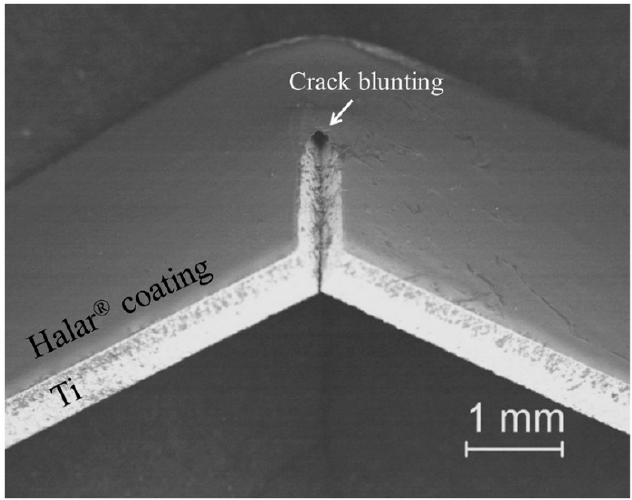
Figure 9. SEM micrograph of the crack growth in a Halar ® -coated Ti specimen. (Reprinted with permission from [61], Elsevier 2018 copyright n. 4710150493083). permission from [61], Elsevier 2018 copyright n.